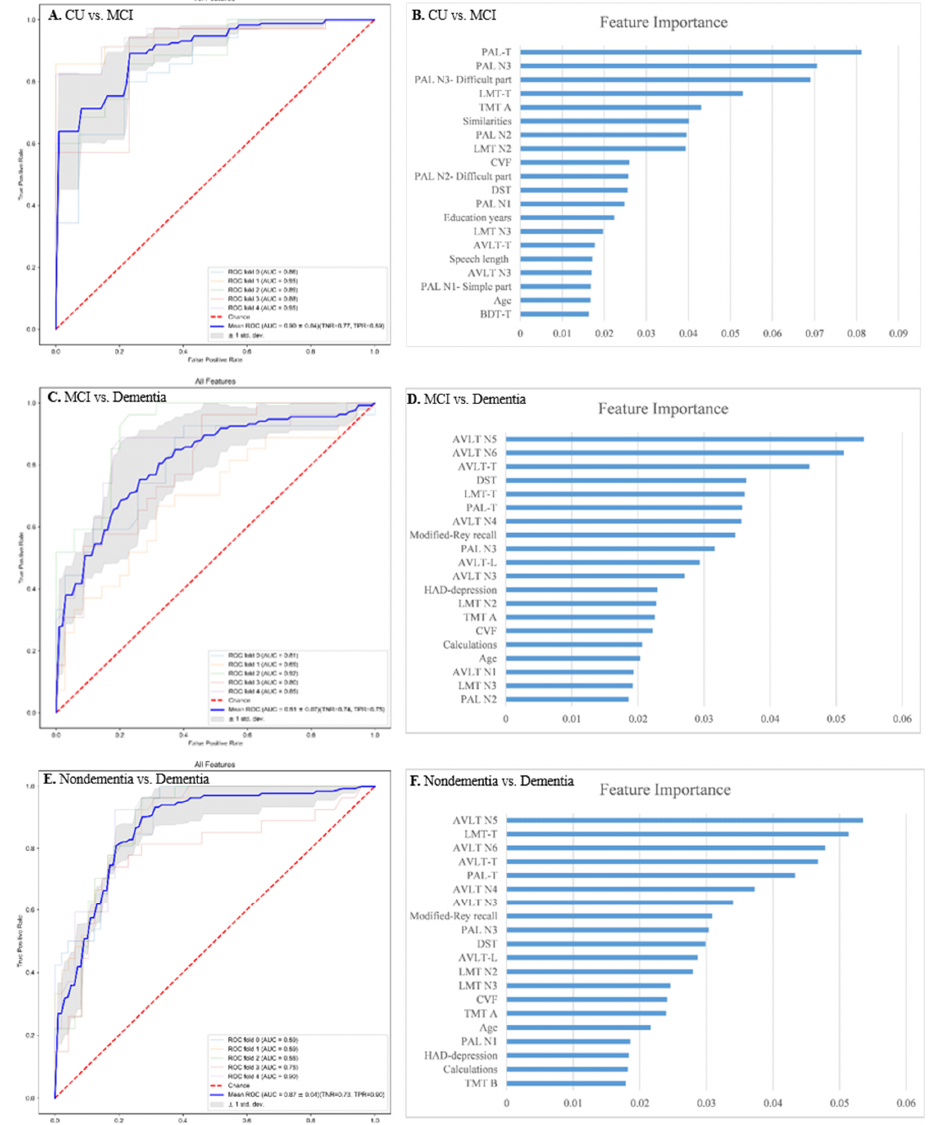
Figure 1. Receiver operating characteristic (ROC) curve analysis for the detection of MCI and dementia and the optimal 20 features. ( A ) ROC curve of all features for the detection of MCI from CU. ( B ) 20 top-ranked features for the detection of MCI from CU. ( C ) ROC curve of all features for the detection of dementia from MCI. ( D ) 20 top-ranked features for the detection of dementia from MCI. ( E ) ROC curve of all features for the detection of dementia from non-dementia. ( F ) 20 top- ranked features for the detection of dementia from non-dementia. Abbreviations: AVLT N1 = the first learning trial of AVLT-H (auditory verbal learning test-Huashan version); AVLT N3 = the third learning trial of AVLT-H; AVLT N4 = the fourth short delayed free recall trial of AVLT-H; AVLT N5 = the fifth long delayed free recall trial of AVLT-H; AVLT N6 = the sixth delayed category cue recall trial of AVLT-H; AVLT-L = total score of AVLT N1, N2,and N3; AVLT-T = total score of AVLT N1, N2, N3, N4 and N5; BDT-T = total score of the block design test; CVF = category verbal fluency; DST = Digit Symbol Test; HAD = hospital anxiety and depression; LMT N2 = the second story of logical memory test (LMT); LMT N3 = the third story of LMT; LMT-T = total score of LMT; PAL N1 = The first learning trial of PAL (paired-associate learning); PAL N1-Simple part = simple word pairs of PAL N1; PAL N2 = The second learning trial of PAL; PAL N2-Difficult part = difficult word pairs of PAL N2; PAL N3 = The third learning trial of PAL; PAL N3-Difficult part = difficult word pairs of PAL N3; PAL-T = total score of PAL N1, N2, and N3; TMT A = trail making test A; TMT B = trail making test